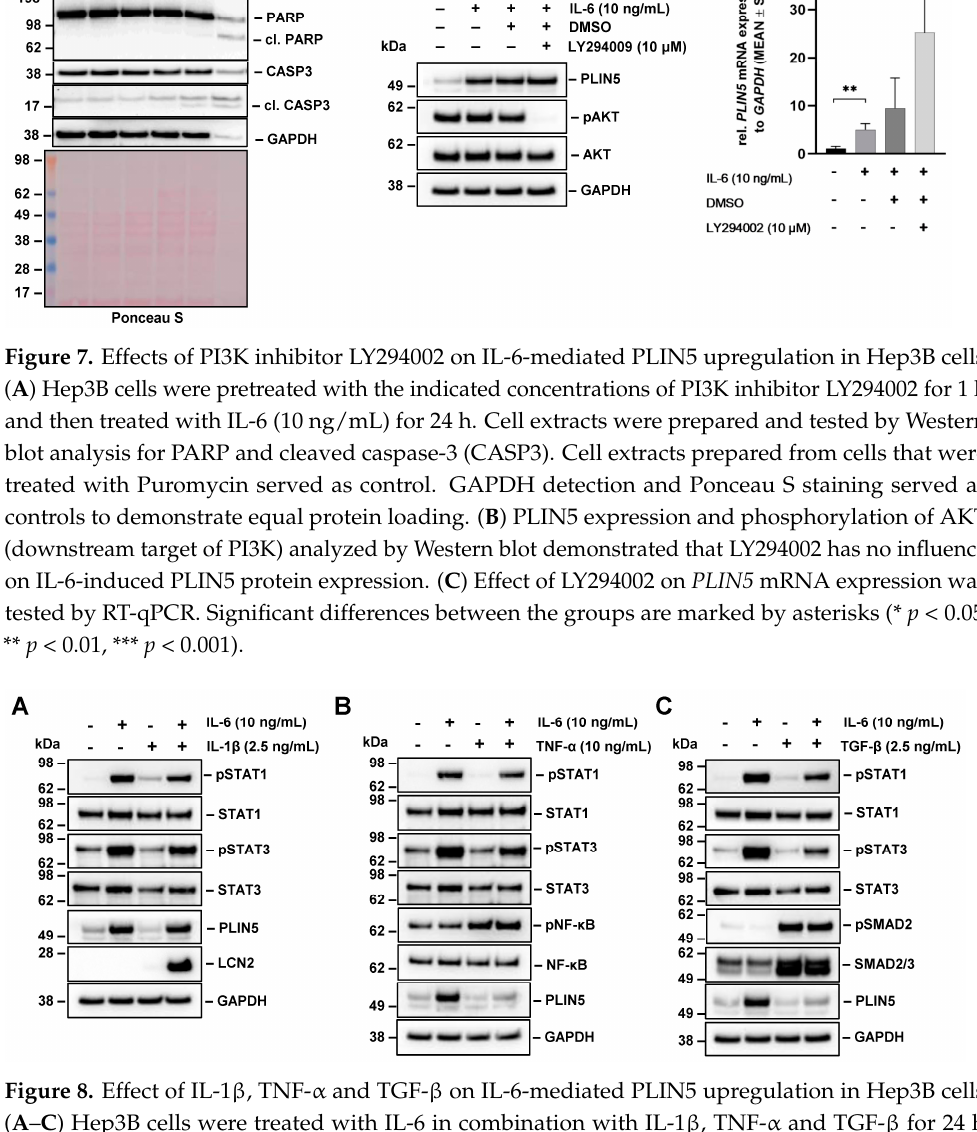
Figure 7. E ff ects of PI3K inhibitor LY294002 on IL-6-mediated PLIN5 upregulation in Hep3B cells . ( A ) Hep3B cells were pretreated with the indicated concentrations of PI3K inhibitor LY294002 for 1 h and then treated with IL-6 (10 ng/mL) for 24 h. Cell extracts were prepared and tested by Western blot analysis for PARP and cleaved caspase-3 (CASP3). Cell extracts prepared from cells that were treated with Puromycin served as control. GAPDH detection and Ponceau S staining served as controls to demonstrate equal protein loading. ( B ) PLIN5 expression and phosphorylation of AKT (downstream target of PI3K) analyzed by Western blot demonstrated that LY294002 has no in fl u- ence on IL-6-induced PLIN5 protein expression. ( C ) E ff ect of LY294002 on PLIN5 mRNA expression was tested by RT-qPCR. Signi fi cant di ff erences between the groups are marked by asterisks (* p < 0.05, ** p < 0.01, *** p < 0.001).